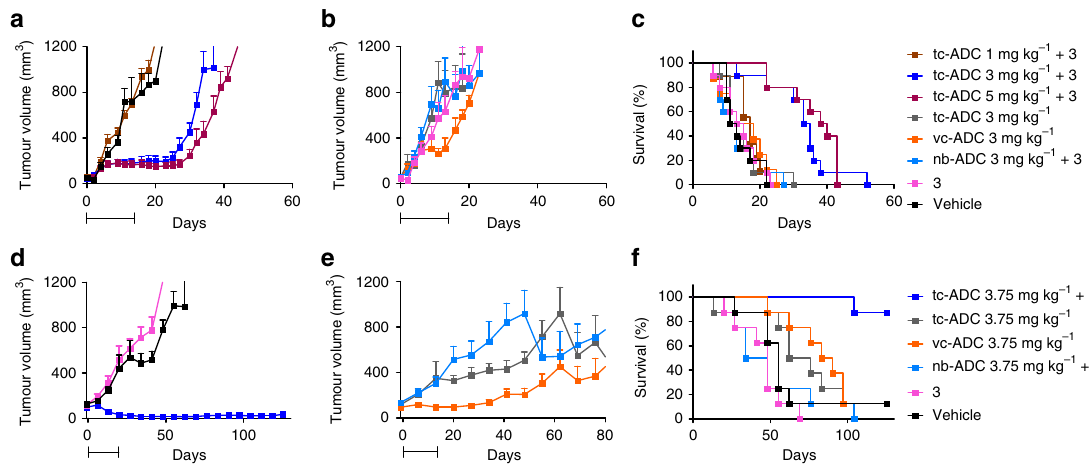
Fig. 6 Therapeutic ef fi cacy of ADCs in a – c LS174T colon carcinoma and d – f OVCAR-3 ovarian carcinoma mouse models ( n = 7 – 10). Mean LS174T tumour volumes (with s.e.m.) in mice that within 2 weeks received i.v. a Four cycles of the combination of tc-ADC (1, 3, 5 mg kg − 1 ) with activator 3 (48 h post- ADC; 0.335 mmolkg − 1 ) or four cycles of vehicle, in comparison to b mice that received i.v. four cycles of tc-ADC alone (3 mg kg − 1 ), 3 alone (0.335 mmol kg − 1 ), enzymatically cleavable vc-ADC (3 mg kg − 1 ) or the combination of non-binding control ( nb-ADC , 3 mg kg − 1 ) with 3 (48 h post-ADC; 0.335 mmol kg − 1 ). Mean OVCAR-3 tumour volumes (with s.e.m.) in mice that within 2 weeks received i.v. d Four cycles of the combination of tc-ADC (3.75 mg kg − 1 ) with 3 (48 h post-ADC; 0.335 mmol kg − 1 ), 3 alone (0.335 mmolkg − 1 ), or vehicle, in comparison to mice that received i.v. four cycles of e tc-ADC alone (3.75 mg kg − 1 ), vc-ADC alone (3.75 mg kg − 1 ) or the combination of nb-ADC (3.75 mg kg − 1 ) with 3 (48 h post-ADC; 0.335 mmol kg − 1 ). Survival curves for c LS174T and f OVCAR-3 bearing mice ( P < 0.0001 and P < 0.0002, respectively; Mantel-Cox test). The bars below the x -axis indicate the treatment periods: four cycles of therapy or controls within 2 weeks (see injection scheme in Supplementary Fig. 21). Note: in d the error bars in the blue line ( tc-ADC 3.75 mg kg − 1 + 3 ) are obscured by the experimental